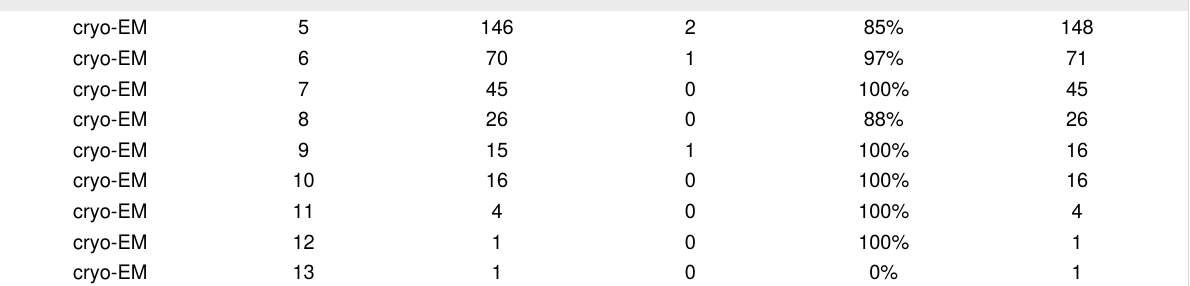
Table 2: Comparison of the successful glycan matches detected by Privateer in the GlyTouCan and the GlyConnect database. a (continued) cryo-EM 5 146 cryo-EM 6 70 1 97% 71 cryo-EM 7 45 0 100% 45 cryo-EM 8 26 0 88% cryo-EM 9 15 1 100% cryo-EM 10 16 0 100% cryo-EM 11 4 0 100% cryo-EM 12 1 0 100% 1 cryo-EM 13 1 0